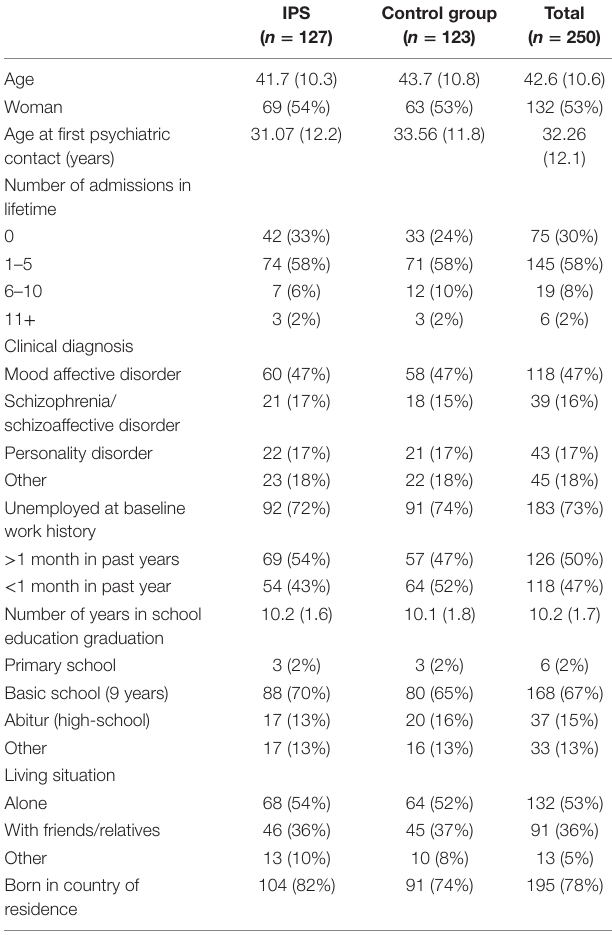
TaBle 1 | Patient characteristics at